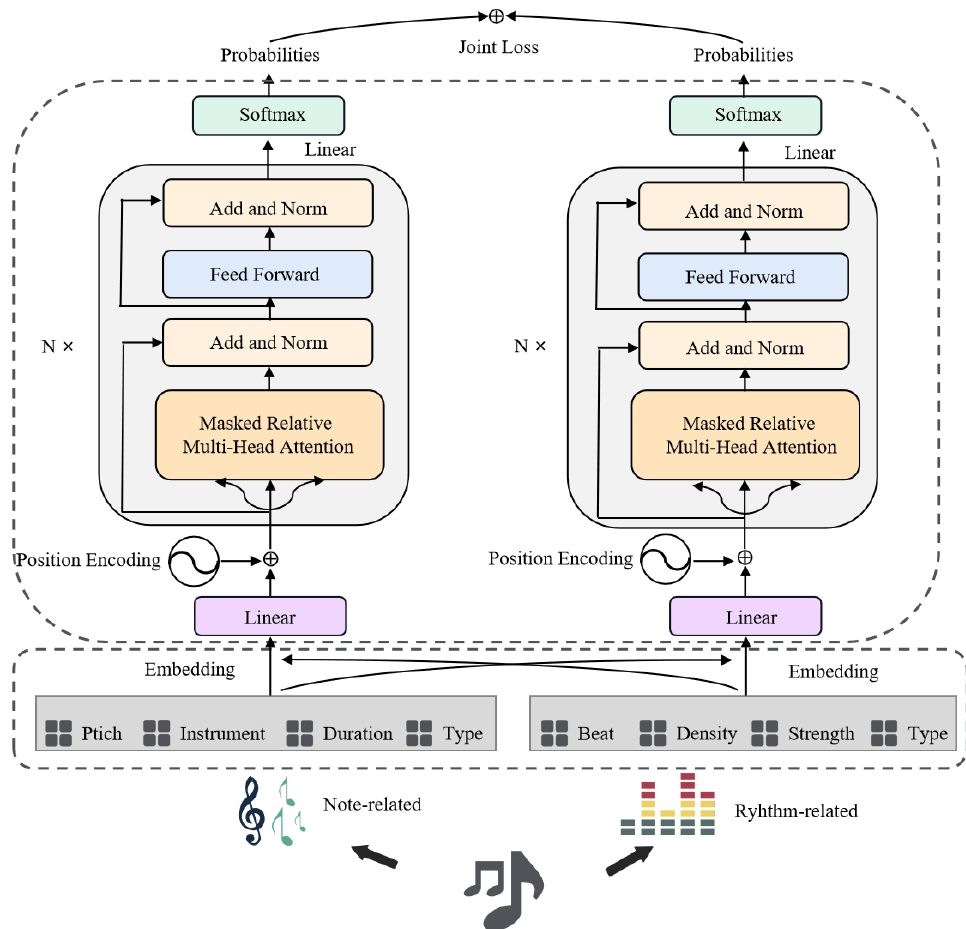
Figure 3. The structure of training two linear Transformers jointly to learn music